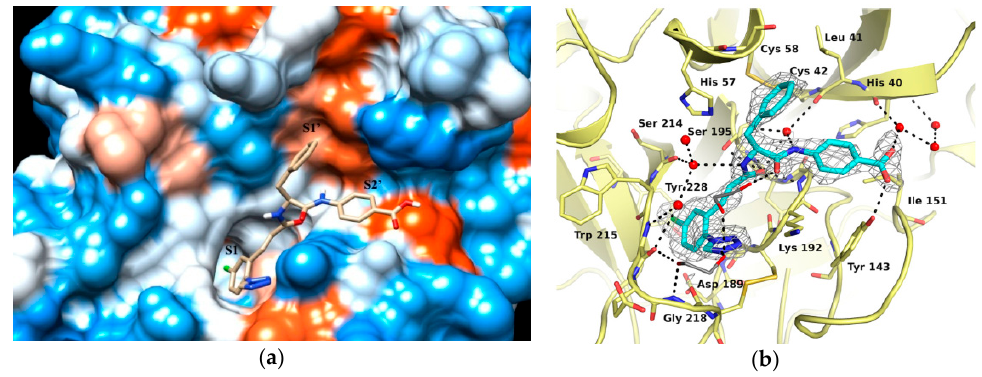
Figure 2. ( a ) Crystal structure of compound 3 in complex with FXIa (Hydrophobicity surface, PDB ID 5E2O); ( b ) Crystal structure of compound 3 in complex with FXIa (Binding mode) [18].